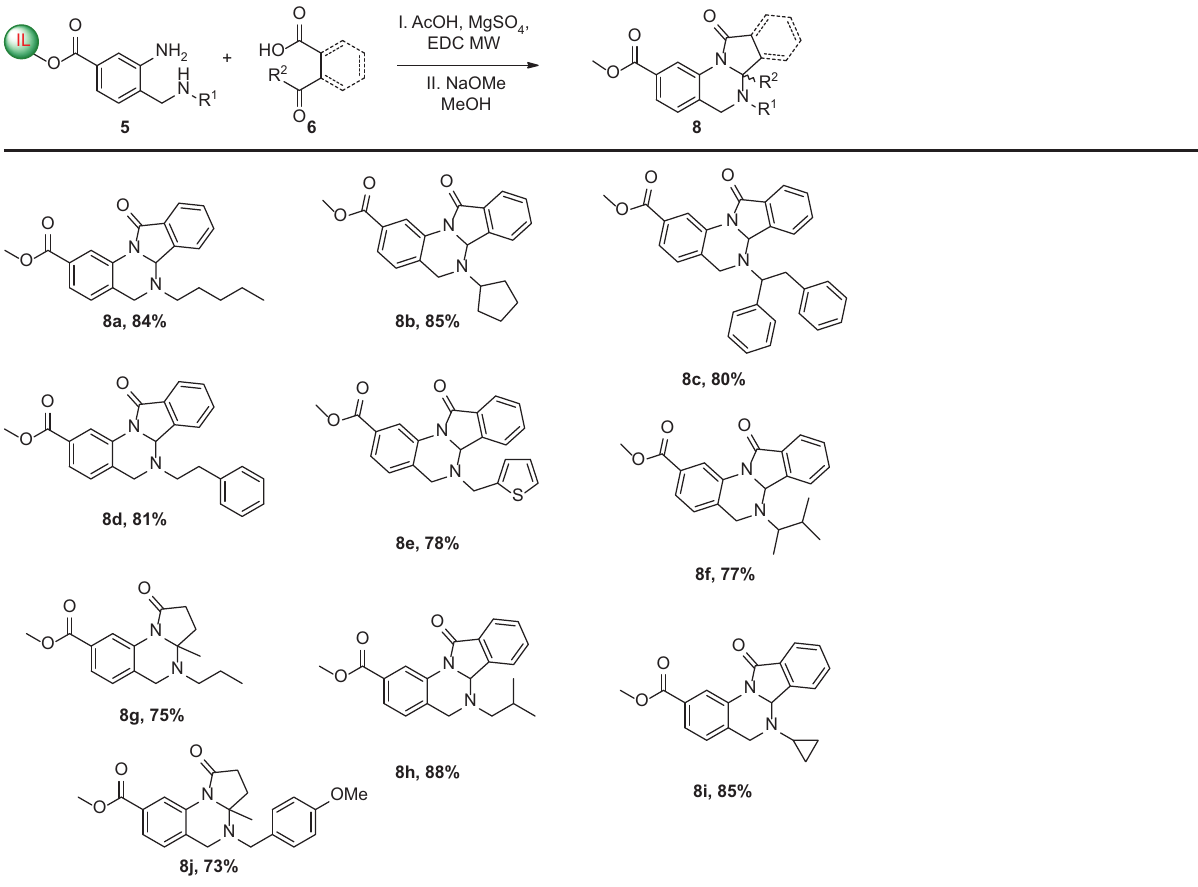
a All reactions were performed under microwave (80 ° C, 10 min) in acetic acid with ethylene dichloride. Isolated yield after column